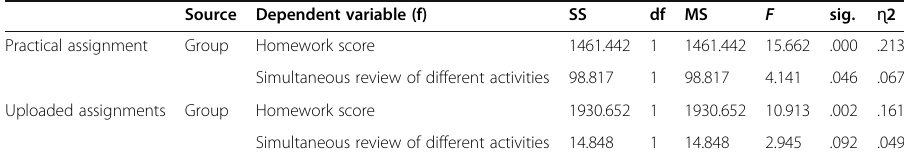
Table 10 Results of the ANOVA test for ICE regarding the assignments Source Dependent variable (f) SS df MS F sig. ɳ